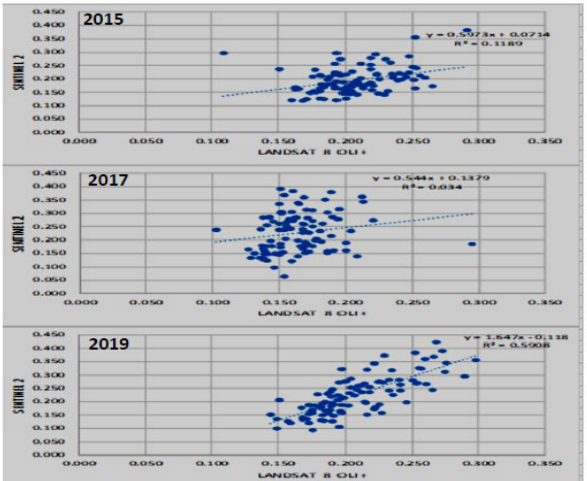
Figure 2: Scatter Plots for NDVI Relationship in Landsat 8 OLI and Sentinel 2A